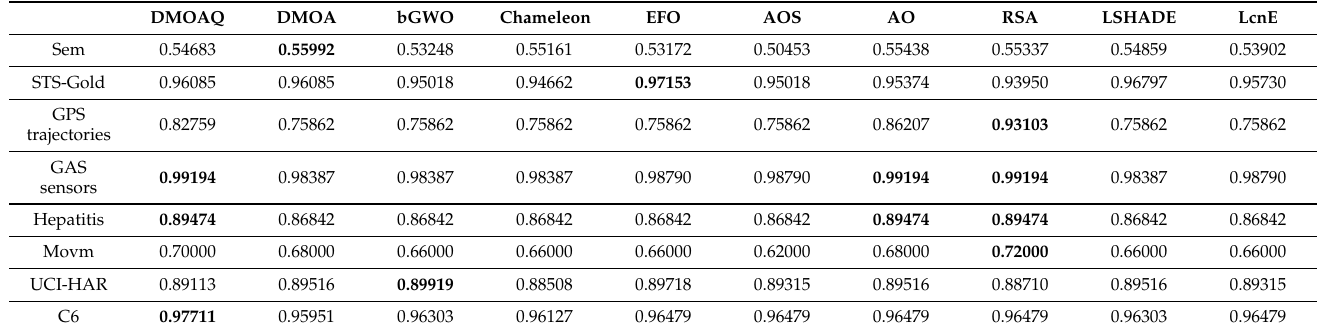
Table 12. Sensitivity obtained from competitive algorithm for all